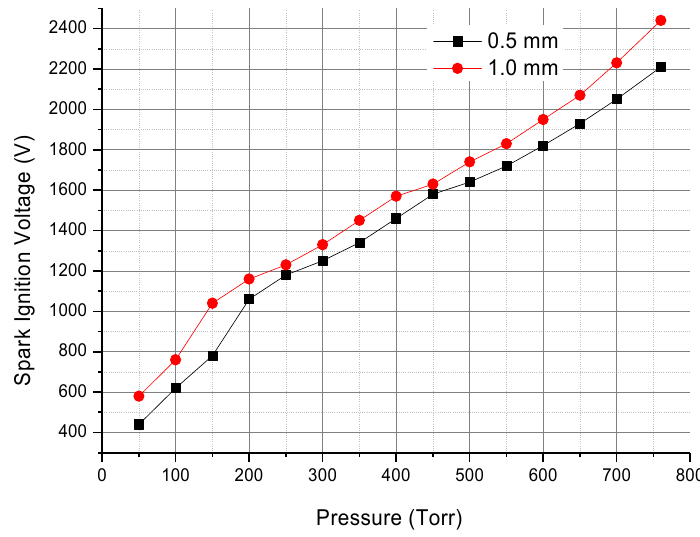
Figure 7. Spark-ignition voltage versus pressure at different electrode gap distances.